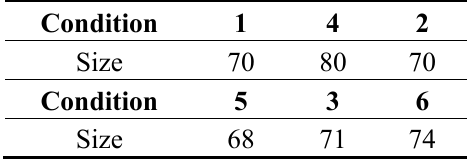
Figure 8. Microstructures of samples fabricated by vacuum die casting with different parameters: Condition 1 ( T = 710 °C, V 2 = 2.5 m/s, P vacuum = 250 mbar); Condition 2 ( T = 710 °C, V 2 = 3.0 m/s, no vacuum); Condition 3 ( T = 710 °C, V 2 = 3.0 m/s, P vacuum = 250 mbar); Condition 4 ( T = 730 °C, V 2 = 2.5 m/s, P vacuum = 250 mbar); Condition 5 ( T = 730 °C, V 2 = 3.0 m/s, no vacuum); Condition 6 ( T = 730 °C, V 2 = 3.0 m/s, P vacuum = 250 mbar). Table 4. Grain size of primary α-Al